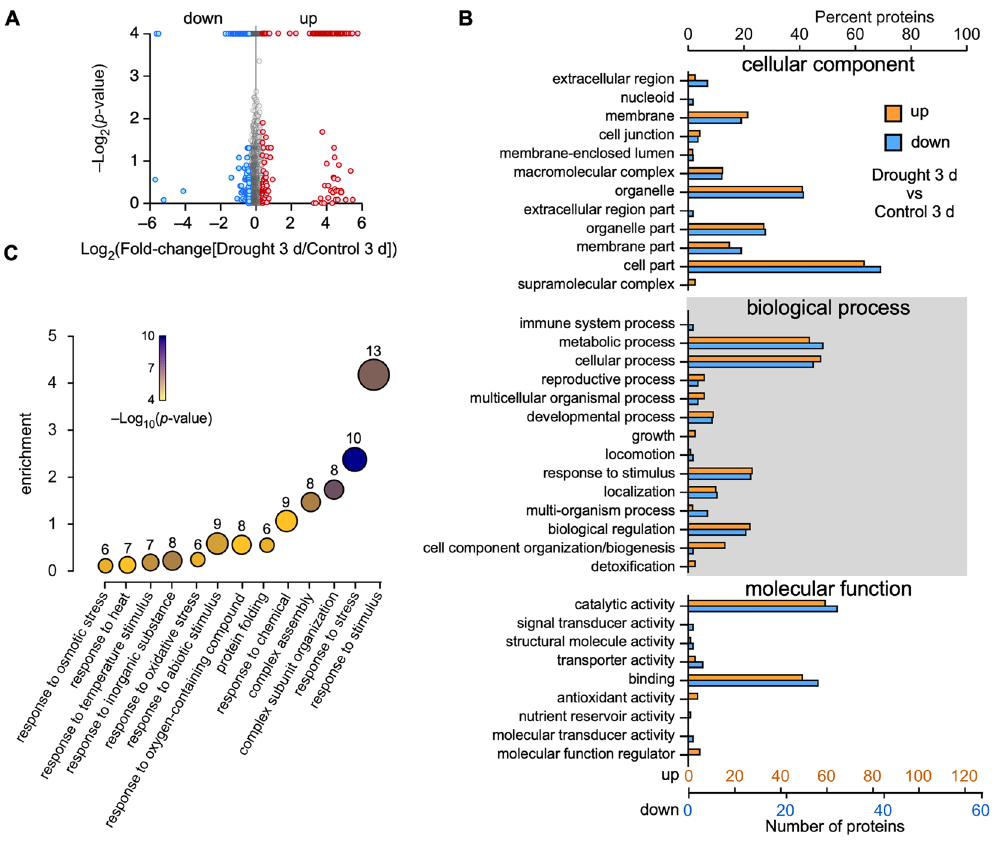
Figure 2. DAPs involved in drought-tolerance pathways. ( A ) Volcano map showing the DAPs identified following the 3-d drought treatment. ( B ) GO annotation for all DAPs. ( C ) GO enrichment analysis of the upregulated proteins after the 3-d drought.